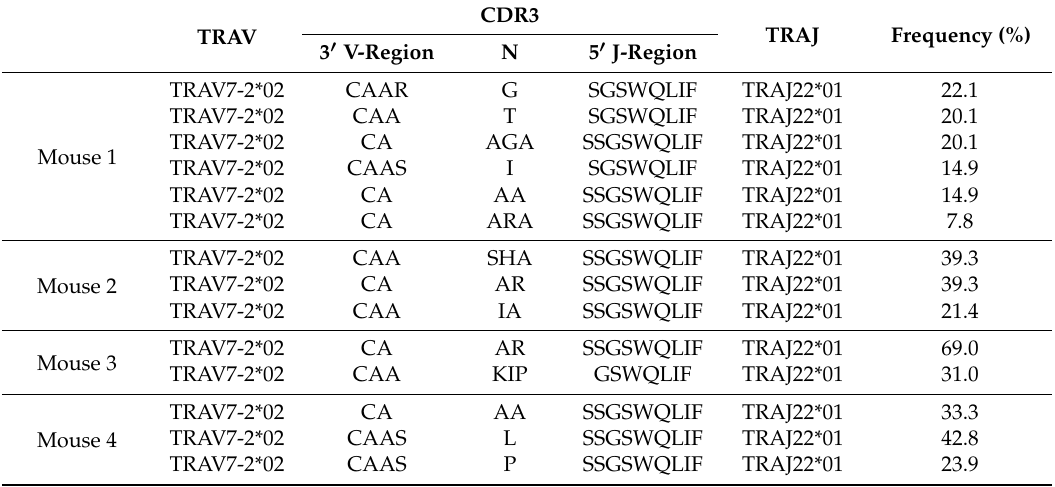
Table 2. The CDR3 amino acid sequences of TRAV7-2*02/TRAJ22*01 in Pd sensitized-WT mice.